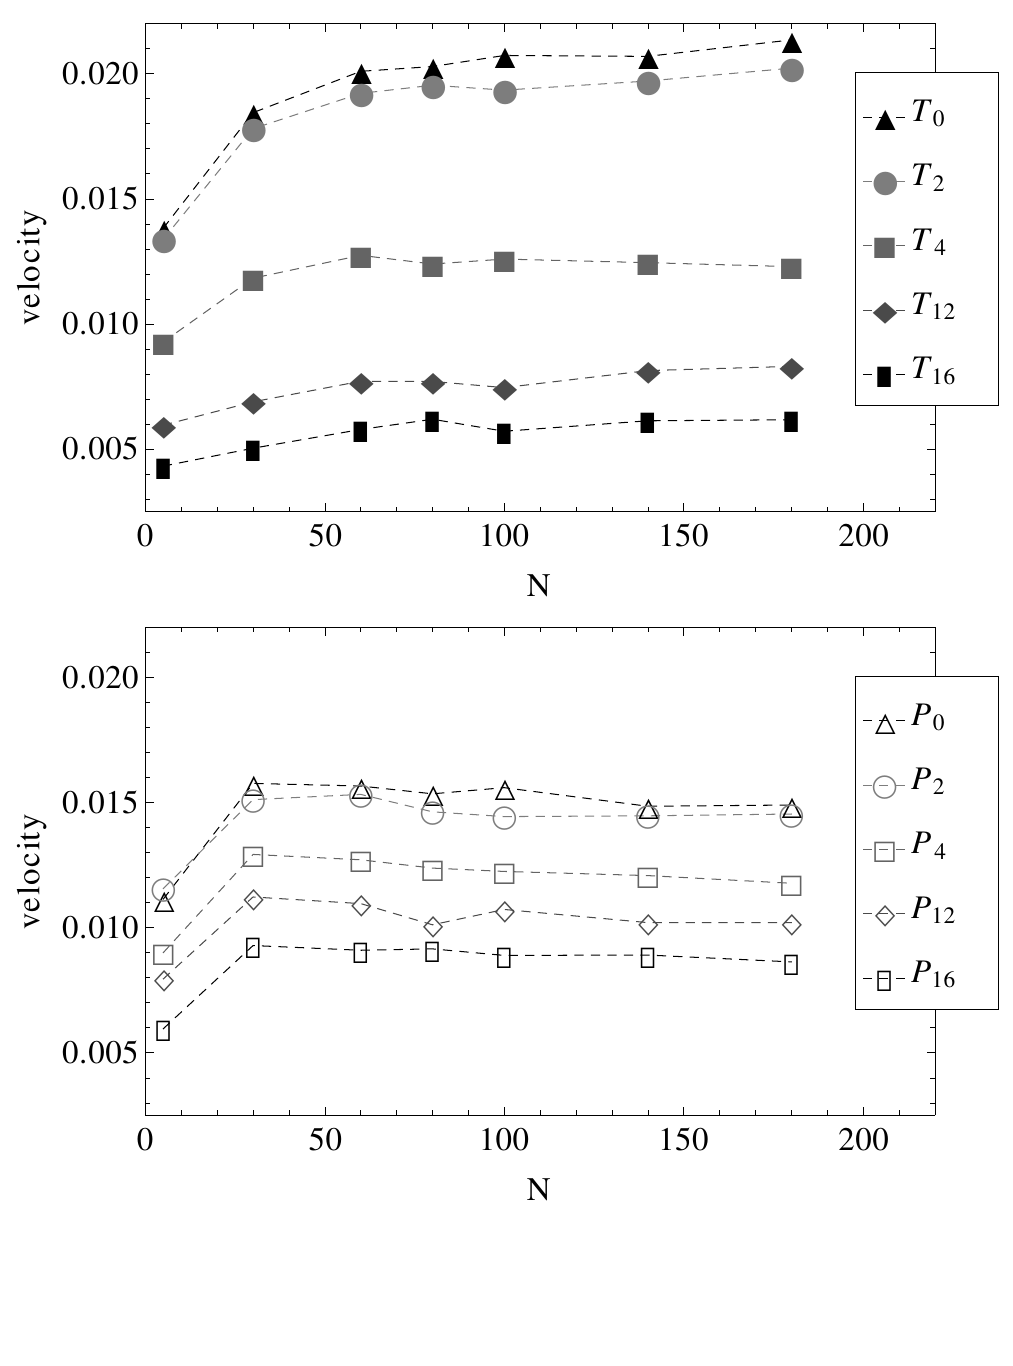
Figure 5. Electrophoretic velocities of charged chains of length N in uniform (index “0”) and variable diameter straight cylinders (indices “2”, “4”, “12” and “16” are in the increasing order of the number of undulations per wavelength, as shown in Figure 1). (Top) The constant applied electric field has both longitudinal and transverse components. (Bottom) The constant applied electric field is parallel to the symmetry